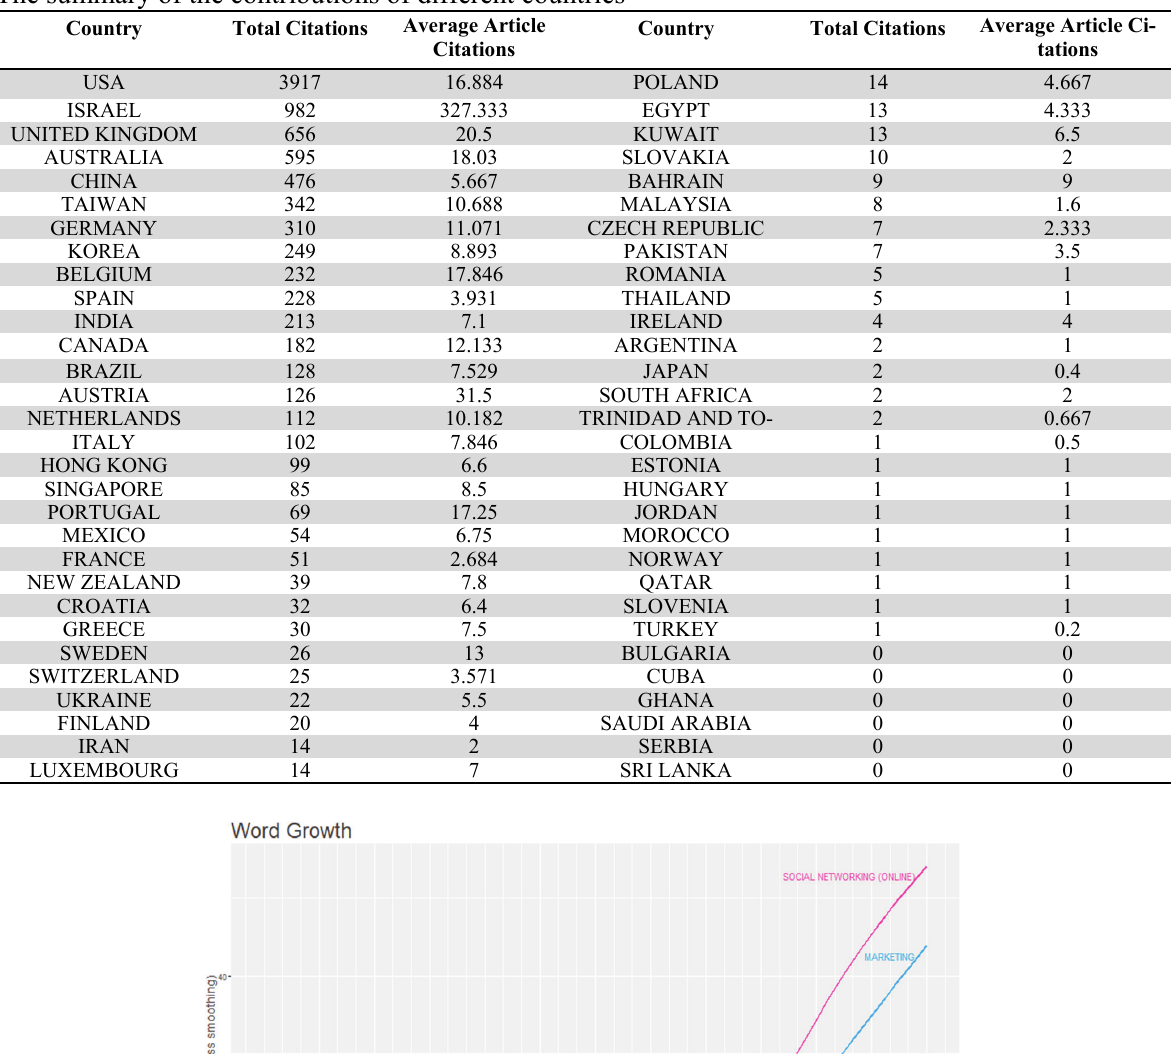
Table 2 The summary of the contributions of different countries Country